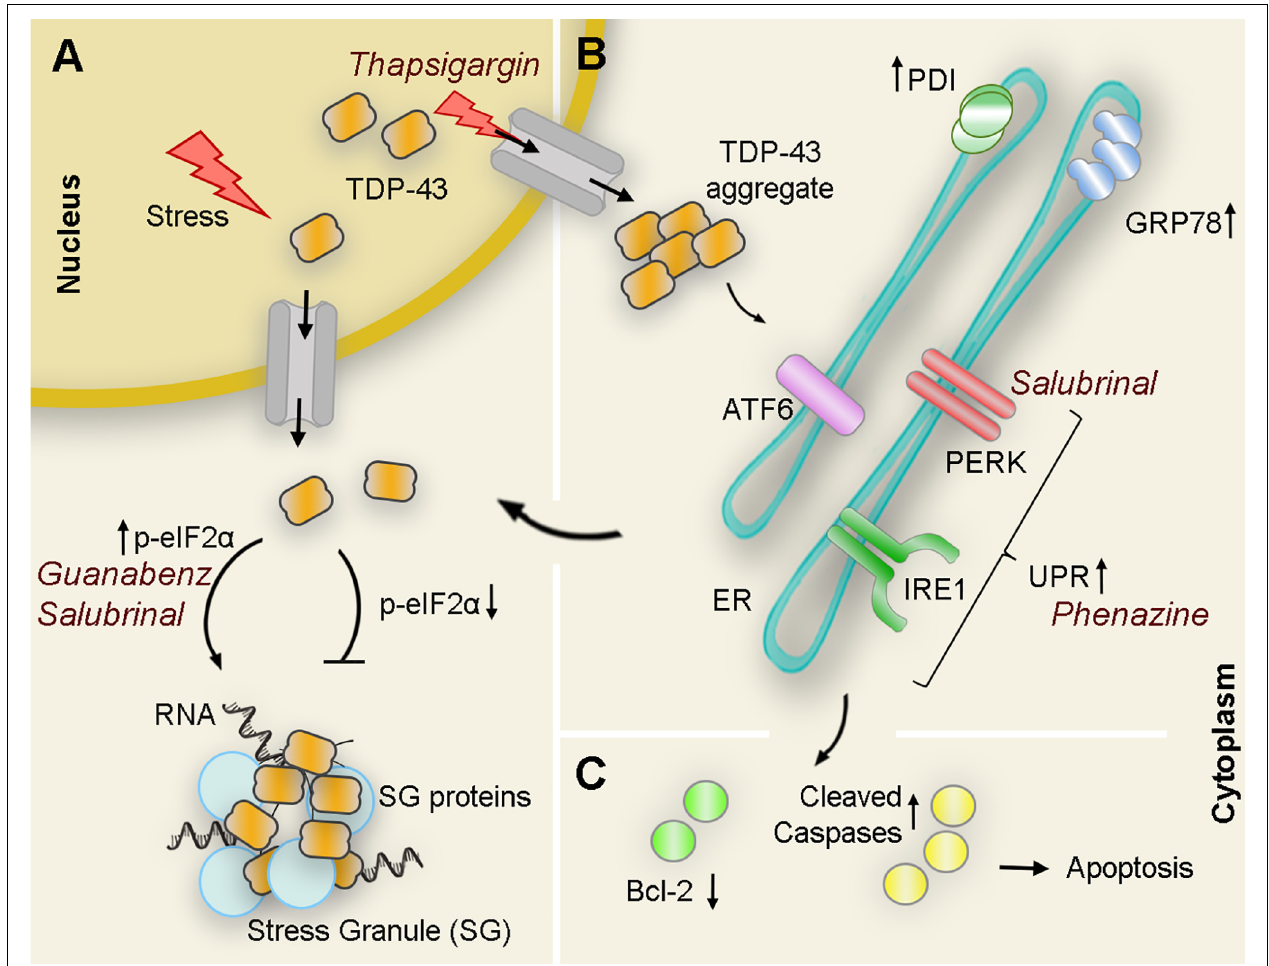
FIGURE 3 | Interplay of TDP43 and ER stress interactions with pharmacological modulators: Under pathological or stressful environmental conditions (i.e., thapsigargin) TDP-43 translocates to the cytoplasm where it forms aggregates or associates with other proteins to form stress granules (SG). (A) Upregulation of the PERK substrate p-eIF2 α directly correlates with SG formation as pharmacological treatments that maintain levels of p-eIF2 α (guanabenz and salubrinal) potentiate ER stress-mediated SG formation. Conversely, genetic down-regulation of peIF2 α suppresses the formation of WT and mutant TDP-43-mediated inclusions. (B) Overexpression of WT or mutant TDP-43 also results in an increase of cleaved ATF6 and IRE1 α substrate Xbp1 as well as ER chaperones PDI and GRP-78 suggesting activation of UPR in the presence of aberrant TDP-43. Pharmacological activation of UPR (i.e., phenazine) decreases TDP-43 insoluble levels. However, chronic activation of ER stress leads to an increase of TDP-43 accumulation in the cytoplasm. (C) If TDP-43-related ER stress is prolonged, proapoptotic cascades are induced, antiapoptotic proteins (Bcl-2 family proteins, green circles) are reduced, while antiapoptotic proteins (cleaved caspases, yellow circles) are induced leading to apoptosis. PDI, protein disulfide